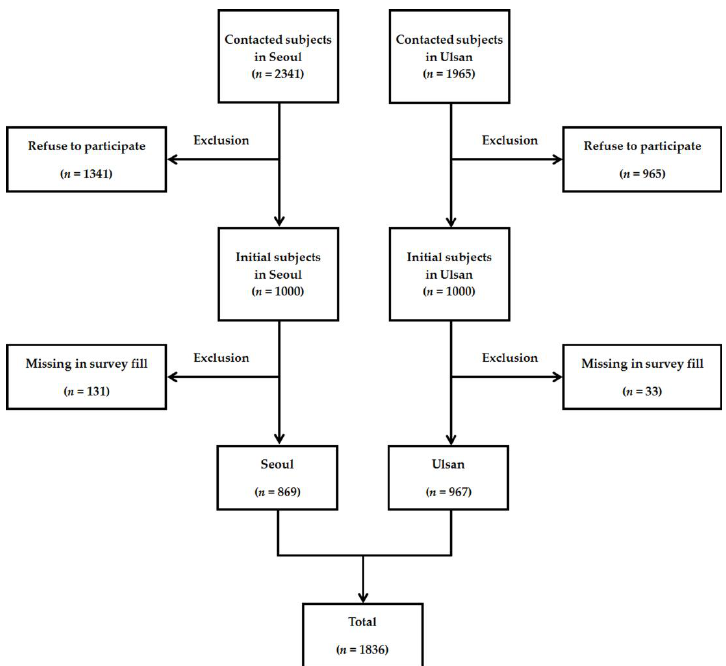
Figure 1. Flowchart of subject selection criteria.